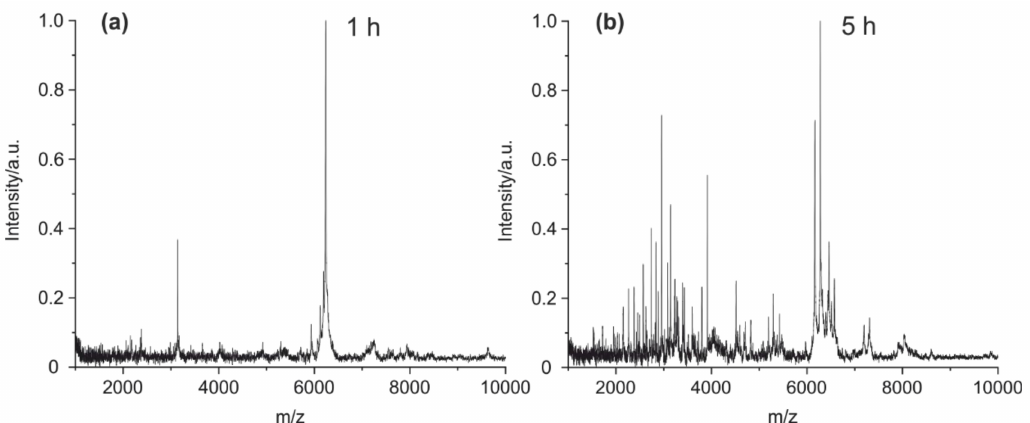
Figure 5. MALDI-TOF MS spectra of ( a ) mouse IgG1 cleaved at 90 ◦ C for one hour and ( b ) mouse IgG1 cleaved for five hours.